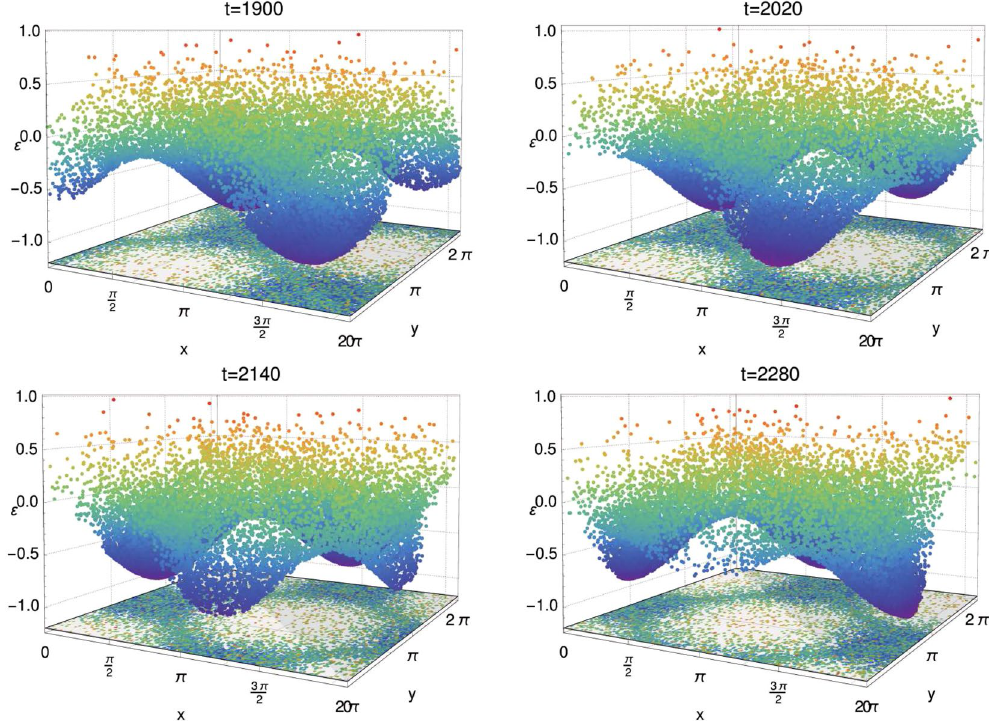
Figure 2. Snapshots taken at different successive times of the positions of the N = 25000 particles in the real space during the quasi-stationary state. The z -axis represents the particle energy computed by the relation in Eq. (17) and defines the particle color. The low energy particles (LEP) plotted in blue remain trapped in the potential cores, the intermediate energy particles (IEP) may hop from one core to another and the few ‘high’ energy particles (HEP) plotted in yellow and red can move freely throughout the system. The bottom plots are projections on a horizontal plane.